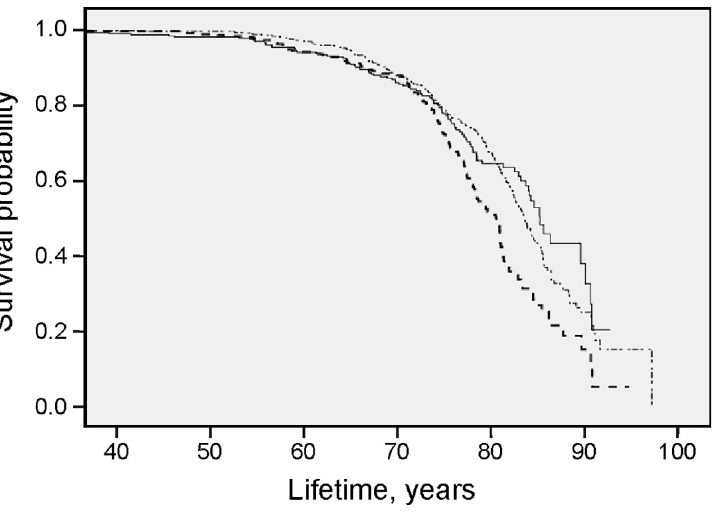
Fig 5. High all-cause mortality with a high BMI in females. Survival probability for all-cause mortality in females with BMI 27 . 6–34 . 2 ( � ─ � � ─ � � ─ � ), BMI < 27 . 6 ( ───── ) and BMI > 34 . 2 (-—-—- -) illustrated with results from Kaplan-Meier